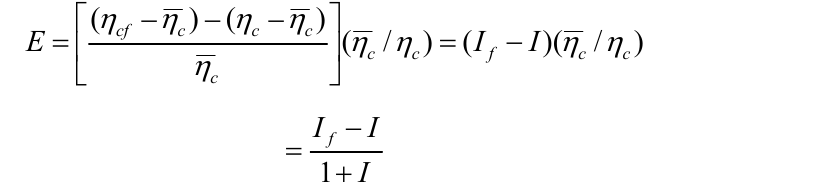
Table 3. Further enhancement in collector efficiency with fin: ( a ) I